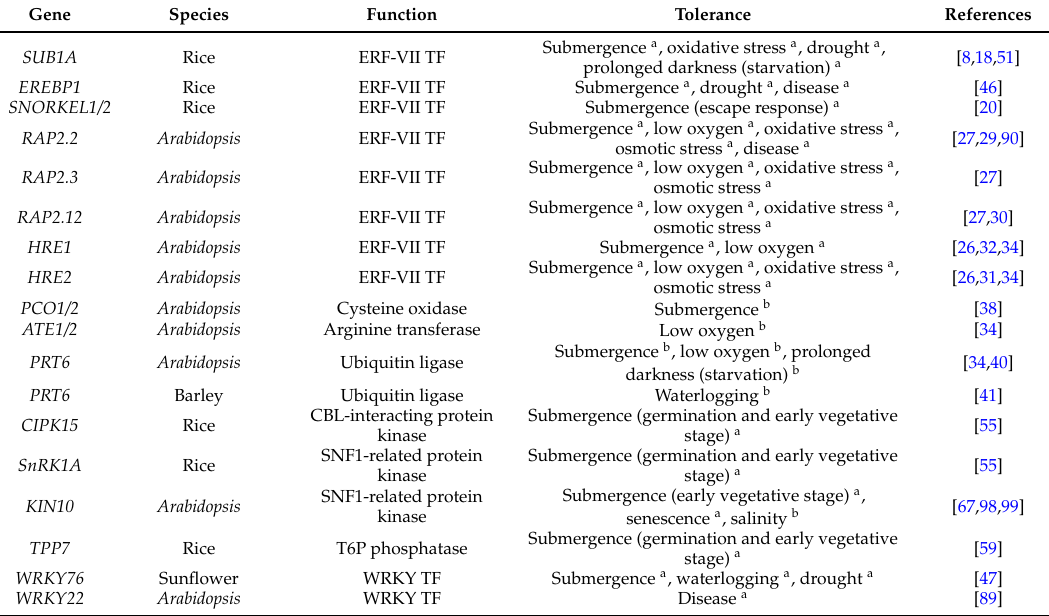
Table 1. Key genes involved in adaptation to submergence and its associated